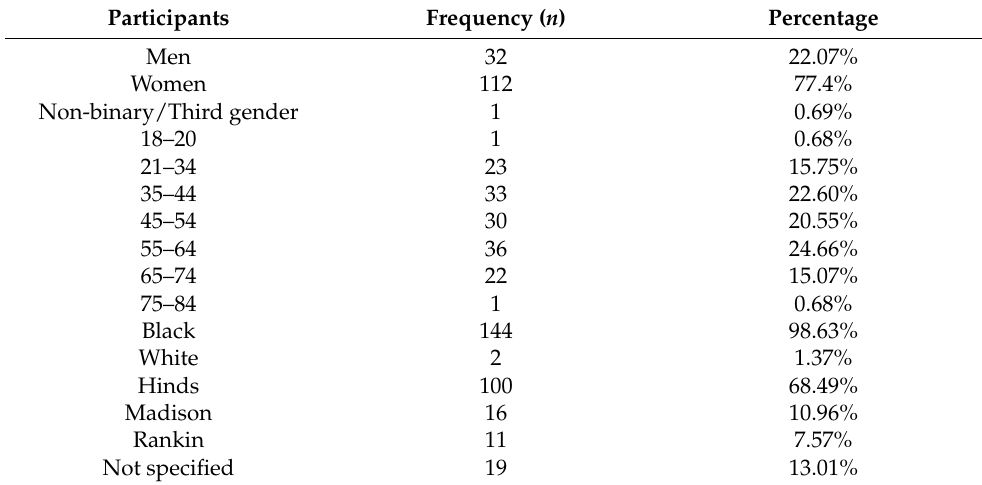
Table 1. Demographic characteristics of the participants.